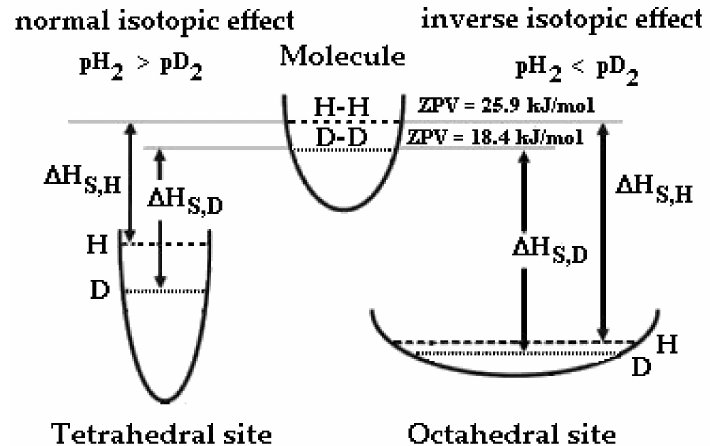
Figure 1. Schematic description of potential wells and zero-point vibration energies of H and D in a H 2 and D 2 molecule, octahedral and tetrahedral sites of Pd-Ag and isotopic e ff ect on the enthalpy of solution, ∆ H S